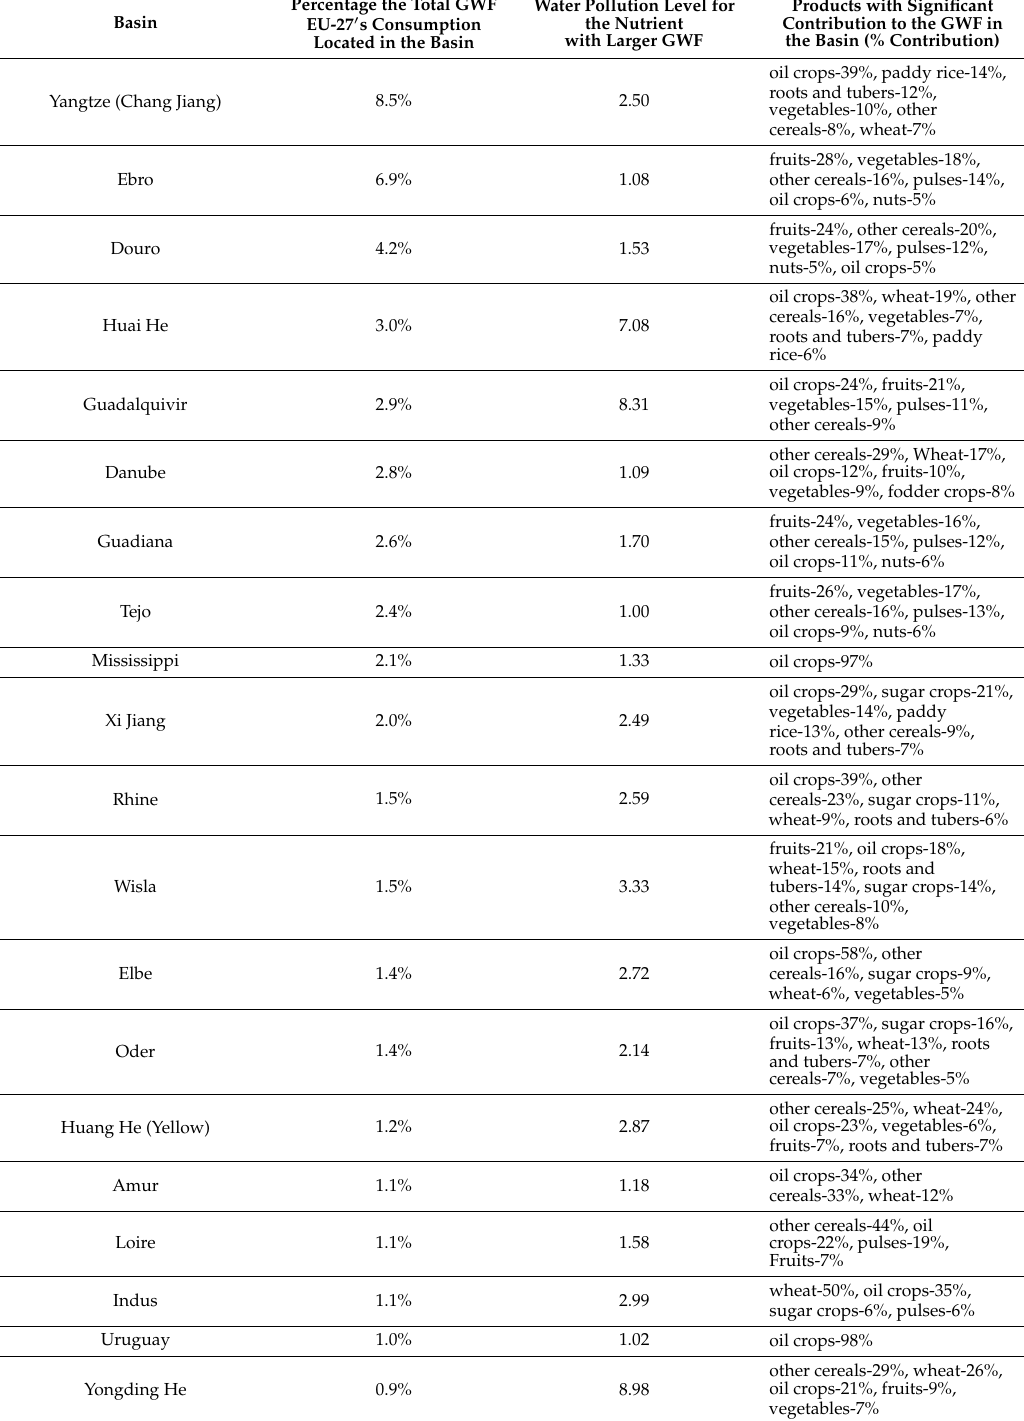
Products with Significant Contribution to the GWF in the Basin (% Contribution)